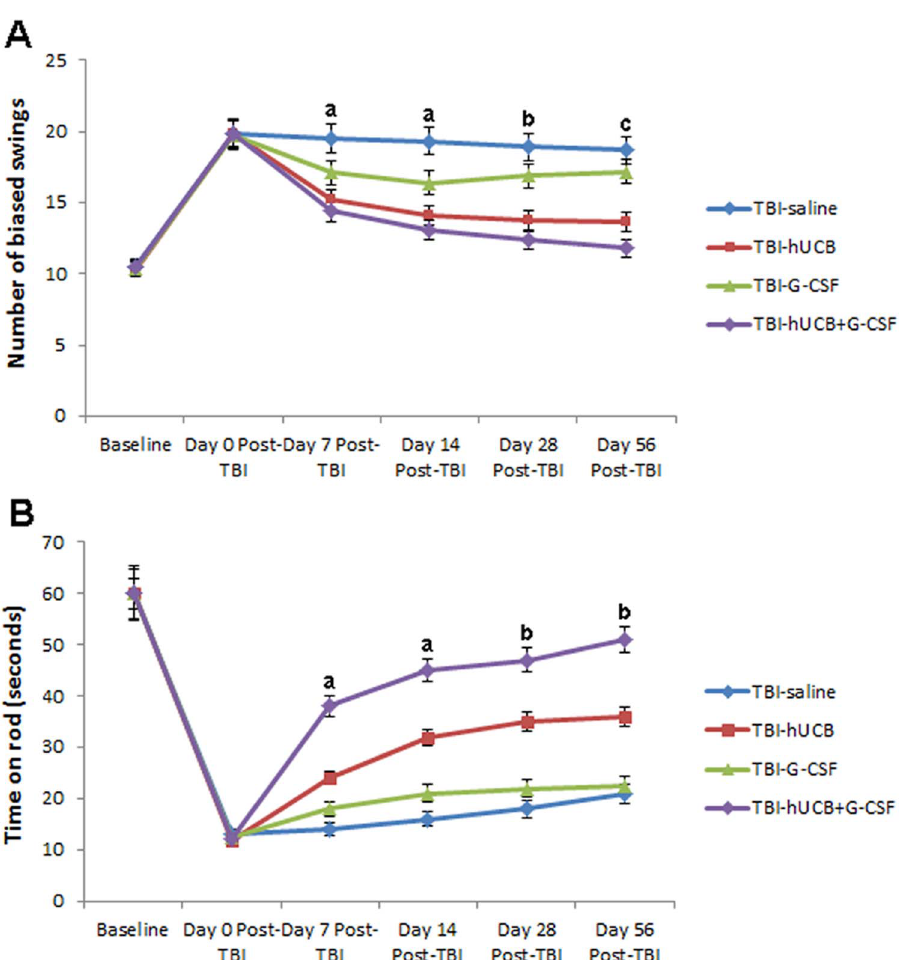
Figure 4. Combined hUCB + G-CSF exert robust functional recovery in chronic TBI. A separate cohort of TBI animals, using the same experimental paradigm above, was subjected to behavioral tests. Elevated body swing tests revealed that animals displayed normal swing activity (average of 10 swings to both left and right side) prior to TBI (Baseline), but exhibited significant swings to one side after TBI (Day 0 post-TBI) (p’s , 0.05 versus Baseline) (Fig. 4A). At post-TBI day 7 and day 14, TBI-hUCB + G-GSF and TBI-hUCB alone promoted significantly better recovery compared to G-CSF alone, although all three groups performed better than TBI-saline group (a) (p’s , 0.05). By day 28, TBI-hUCB and TBI-hUCB + G-CSF were the only two groups that displayed significant recovery of normal swing activity (p’s , 0.05), while TBI-GCSF group reverted to Day 0 post-TBI levels and did not significantly differ from TBI-saline (Fig. 4A) (p . 0.05). By day 56, TBI-hUCB + G-GSF and TBI-hUCB alone were still significantly displaying near normal swing activity (p’s , 0.05 versus TBI-G-CSF or TBI-saline), but the TBI-hUCB + G-GSF showed significantly better recovery than TBI-hUCB alone (c) (p , 0.05). In addition TBI-GCSF group did not significantly differ from TBI-saline by day 56 (Fig. 4A) (p . 0.05). Rotorod tests revealed that animals learned to balance on the rotating rod (maximum of 60 seconds) prior to TBI (Baseline), but exhibited significant reduction